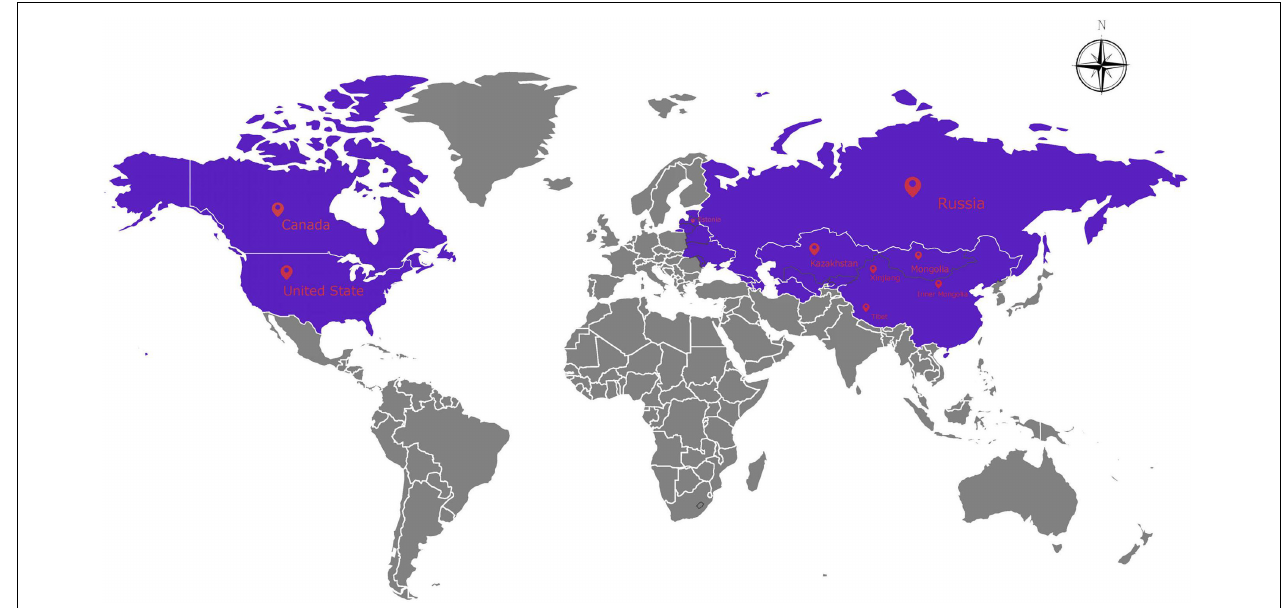
FIGURE 1 | The distribution of 480 Psathyrostachys juncea accessions included in the present